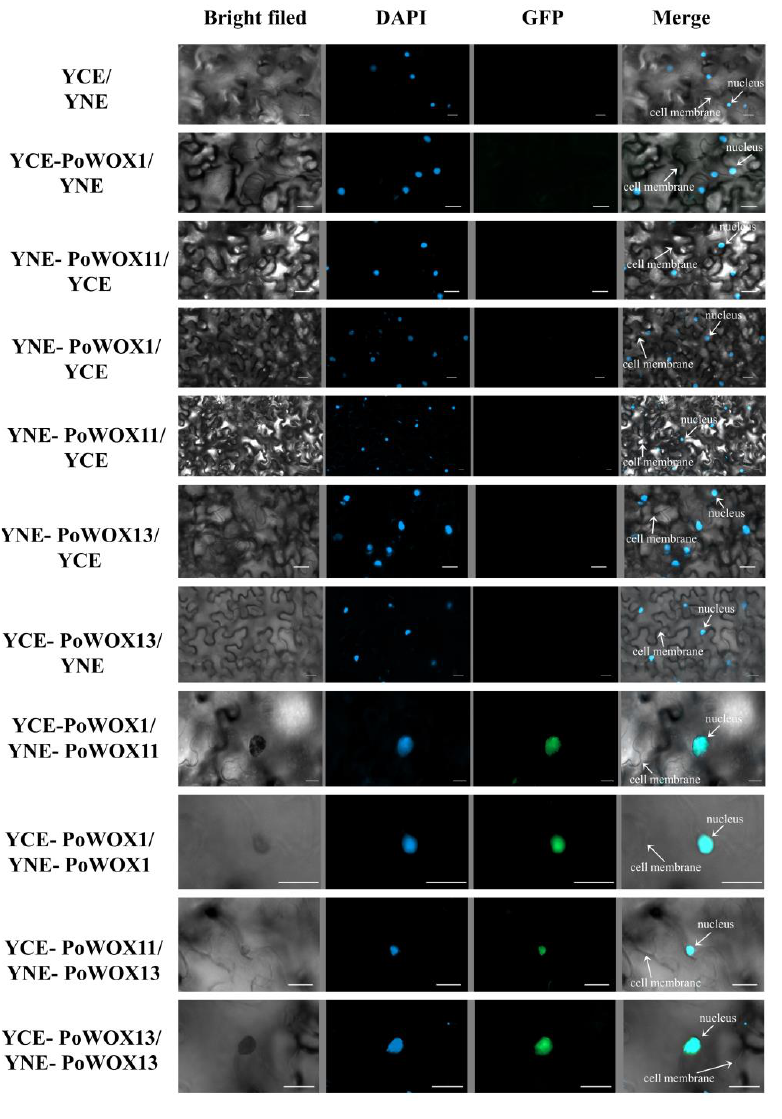
Figure 9. Subcellular localization analysis of 35::PoWOX-GFP fusion protein. 35::PoWOX-GFP vector was used to infiltrate the lower epidermis of tobacco mediated by A. tumefaciens GV3101. Fusion protein expression was observed under Zeiss Axio Imager M2 microscope. Tobacco leaf cells were stained with DAPI (1 μg /mL). Green fluorescence shows the fusion protein location and blue fluorescence is the nuclear signal localized by DAPI for bright field, DAPI, GFP, and merge, respectively. Positive control is 35S::GFP empty. The white arrows indicate the location of the nucleus and the cell membrane. Th e scale bar is 20 μm.